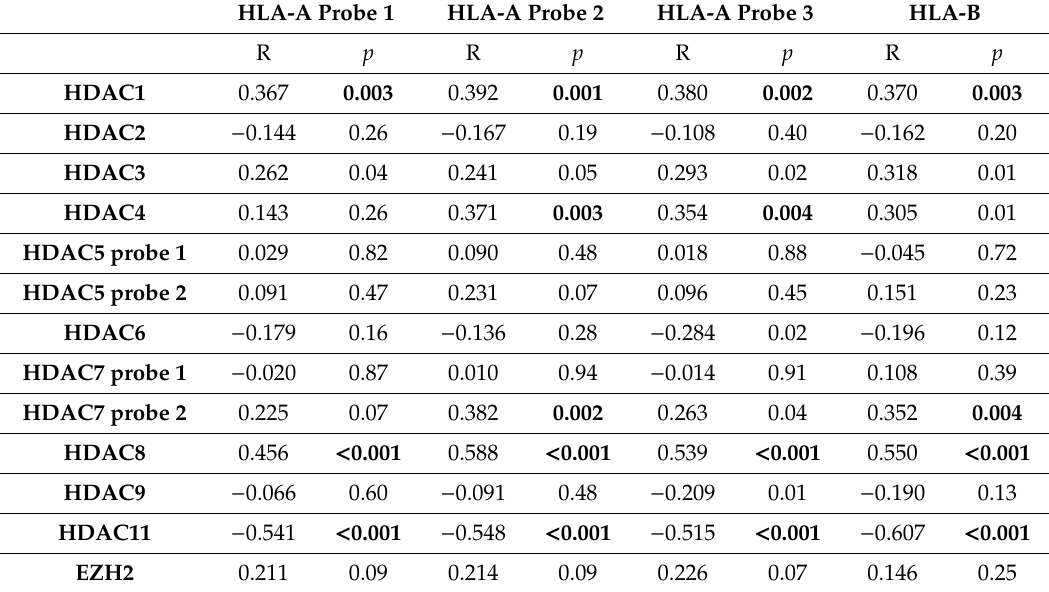
Table 1. Correlation between mRNA expression levels (determined by Illumina array) of di ff erent HDACs and EZH2 and the expression of HLA-A (three probes) and HLA-B. R = two-tailed Spearman correlation coe ffi cient. Following Bonferroni correction, p ≤ 0.005 is considered significant, and indicated in